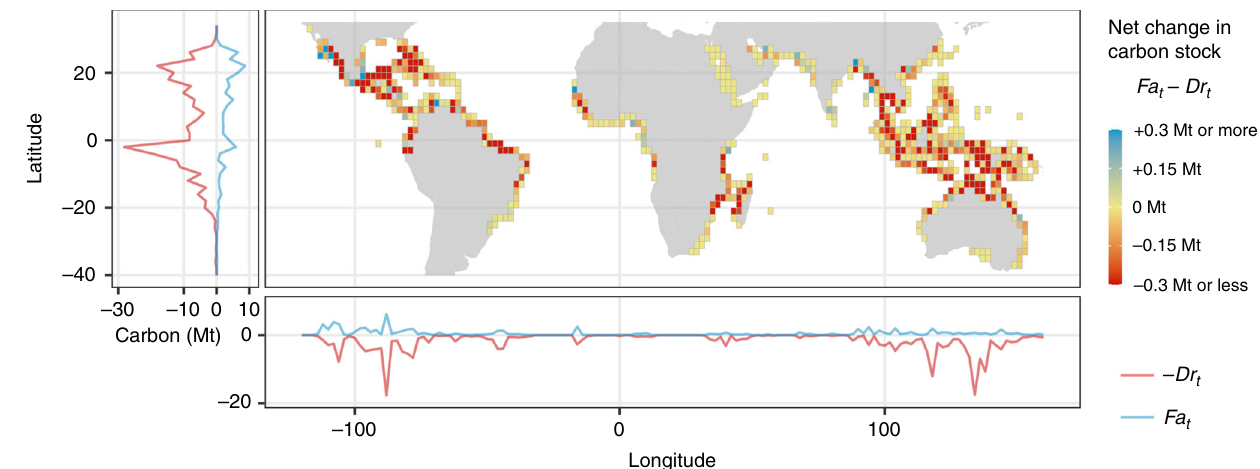
Fig. 2 Spatial variation in net changes in mangrove carbon stock. Net change in mangrove carbon stock was quanti fi ed as ( Fa t − Dr t ). Simulated values for each patch of mangrove gain and loss were aggregated to 2° grid resolution by taking the sum of all patches of mangrove gain and loss with centroids falling within each grid cell. Side panels indicate latitudinal and longitudinal variation in loss of mangrove carbon stocks due to deforestation ( − Dr t ) and gain due to forestation ( Fa t ). Paci fi c island and New Zealand mangroves not shown.